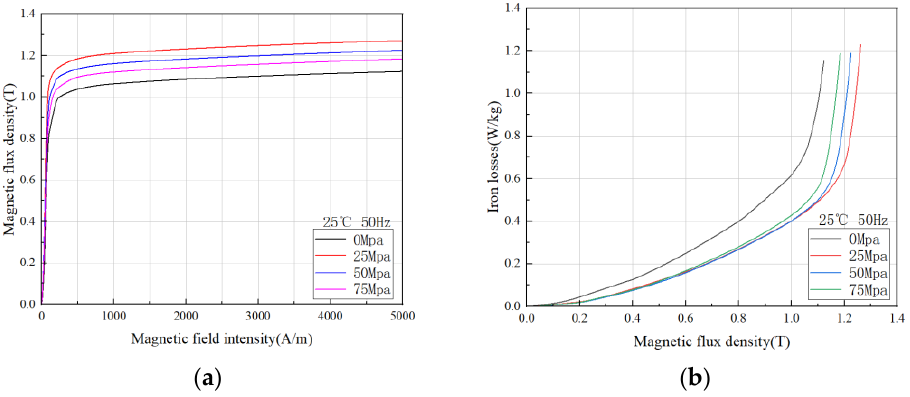
Figure 6. Magnetic properties of grain-oriented silicon steel under different stress fields ( a ) magnet- ization curves of H-80 material @25 °C and 50 Hz under different stresses; ( b ) iron loss curves of H- zation curves of H-80 material @25 ◦ C and 50 Hz under different stresses; ( b ) iron loss curves of H-80 80 material @25 °C and 50 Hz under different stresses . material @25 ◦ C and 50 Hz under different